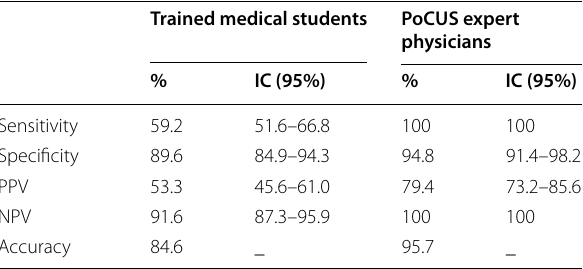
Table 2 Comparison of the results of the evaluation of